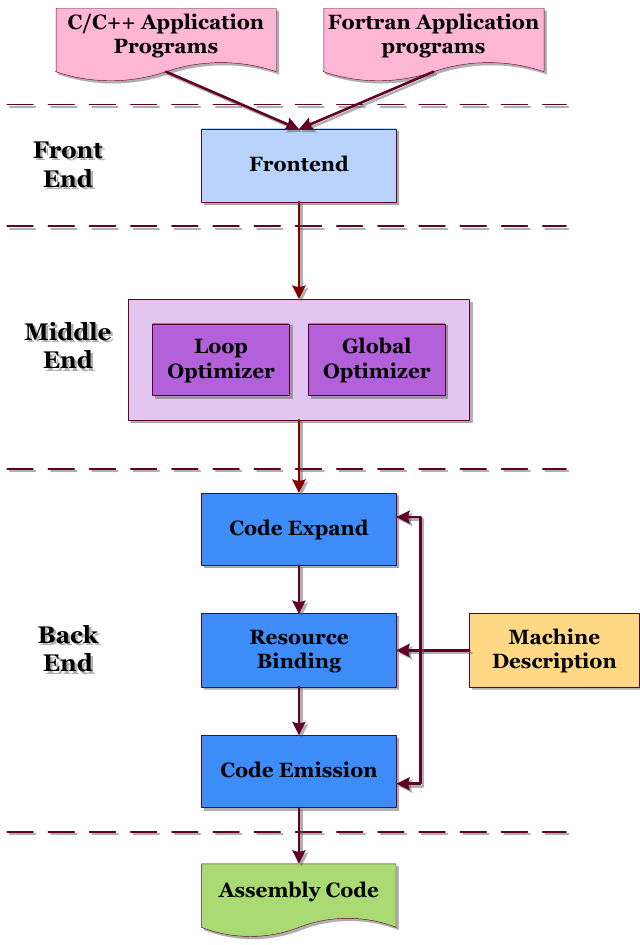
Figure 2. Architecture of the Magnolia